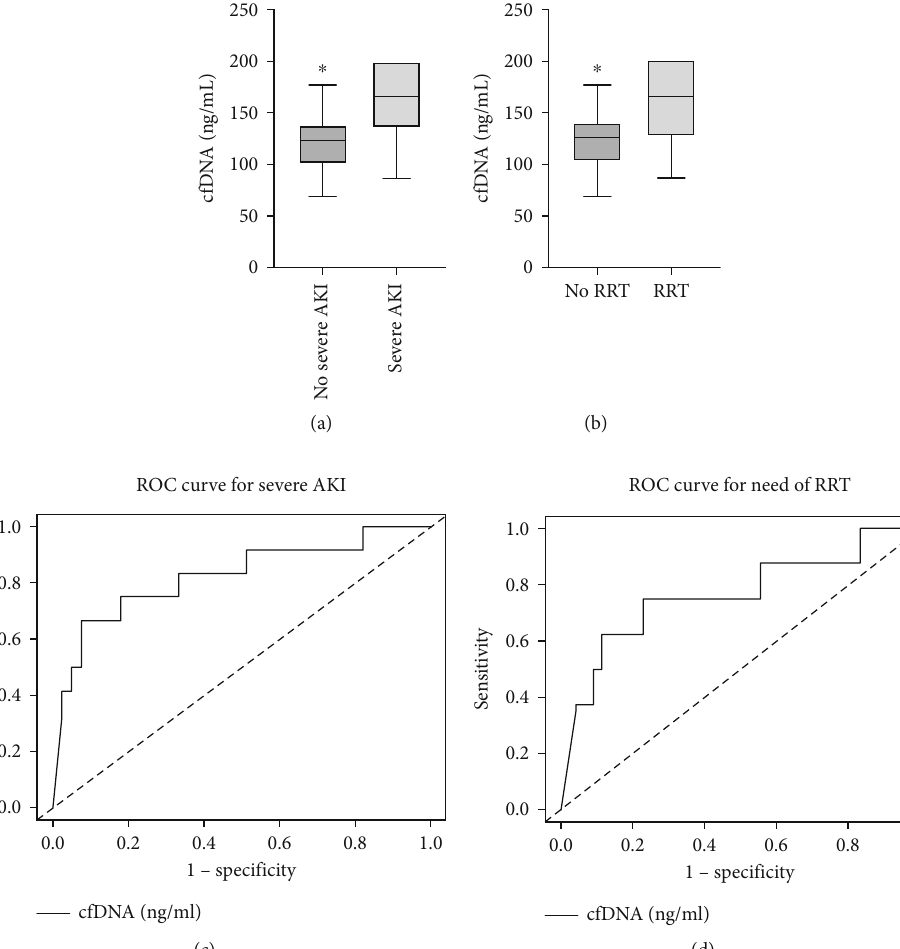
Figure 1: Cell-free DNA (cfDNA) levels in COVID-19 patients based on severity of acute kidney injury (AKI) (a) and need for renal replacement therapy (RRT) (b); receiver operating characteristic curve (ROC) of cfDNA for severe AKI (c, left) ( area underthe curve ð AUC Þ = 0 : 82 (95% CI: 0.67-0.97)); and ROC of cfDNA for the need for RRT (c, right) ( AUC = 0 : 76 (95% CI: